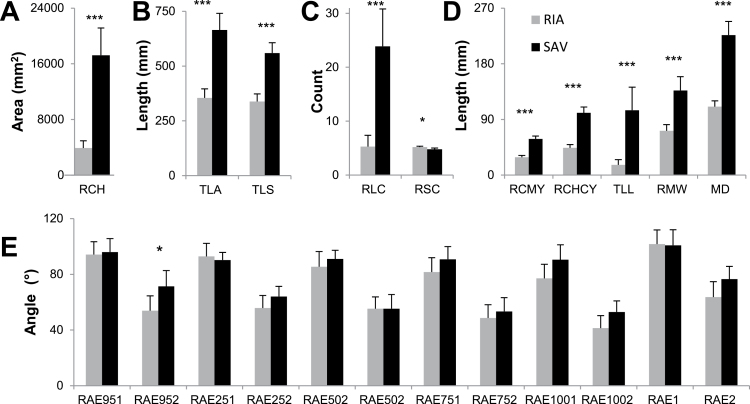
Phenotypic variation in parental line root traits (n = 18 for Savannah; n = 22 for Rialto). (A) Area of convex hull (RCH). (B) Length of total root system (TLA) and seminal roots (TLS). (C) Number of lateral (RLC) and seminal (RSC) roots. (D) Vertical co-ordinates of centre of mass (RCMY) and convex hull (RCHCY); total length of lateral roots (TLL); maximum horizontal width of root system (RMW); maximum depth of root system (MD). (E) Angle measurements. Error bars are two standard errors of the means; *, P < 0.05; ***, P < 0.001.